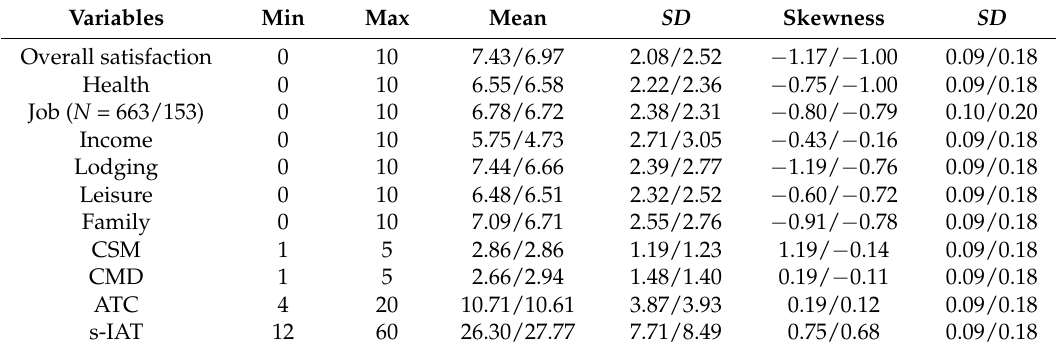
Table 2. Means and Standard Deviation, Minimum, Maximum, and Skewness for life satisfaction variables, and Internet variables for business-commuters (BC) and private commuters